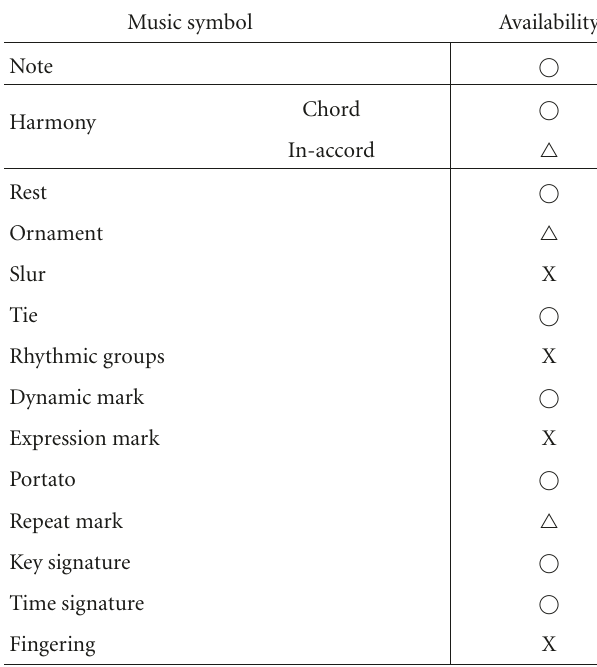
Table 5: The processing time required transcribing. Table 6: Available Braille signs for music symbols.